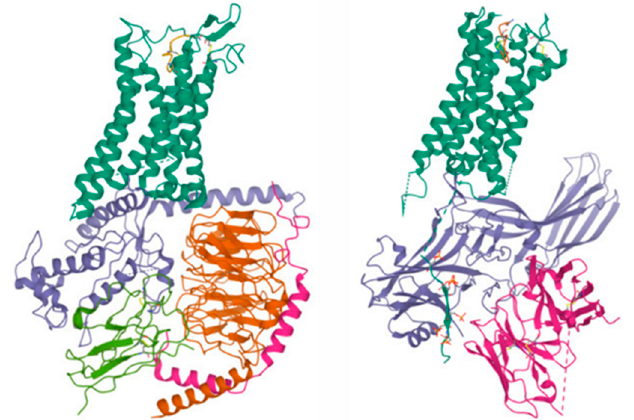
Figure 1. Cryo-EM structures of the V2R complexed with AVP and associated with either the tri- meric Gs protein (left, referred to as “T state”, PDB: 7BB7) or β -arrestin2 (right, PDB: 7r0c). Taken from PDB.